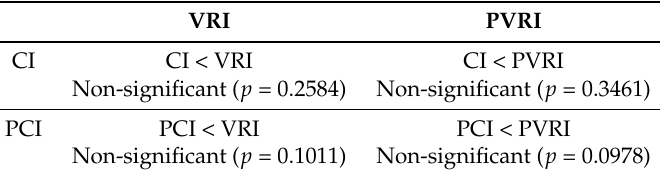
Table 8. T-test with pairs of interfaces in terms of SAGAT